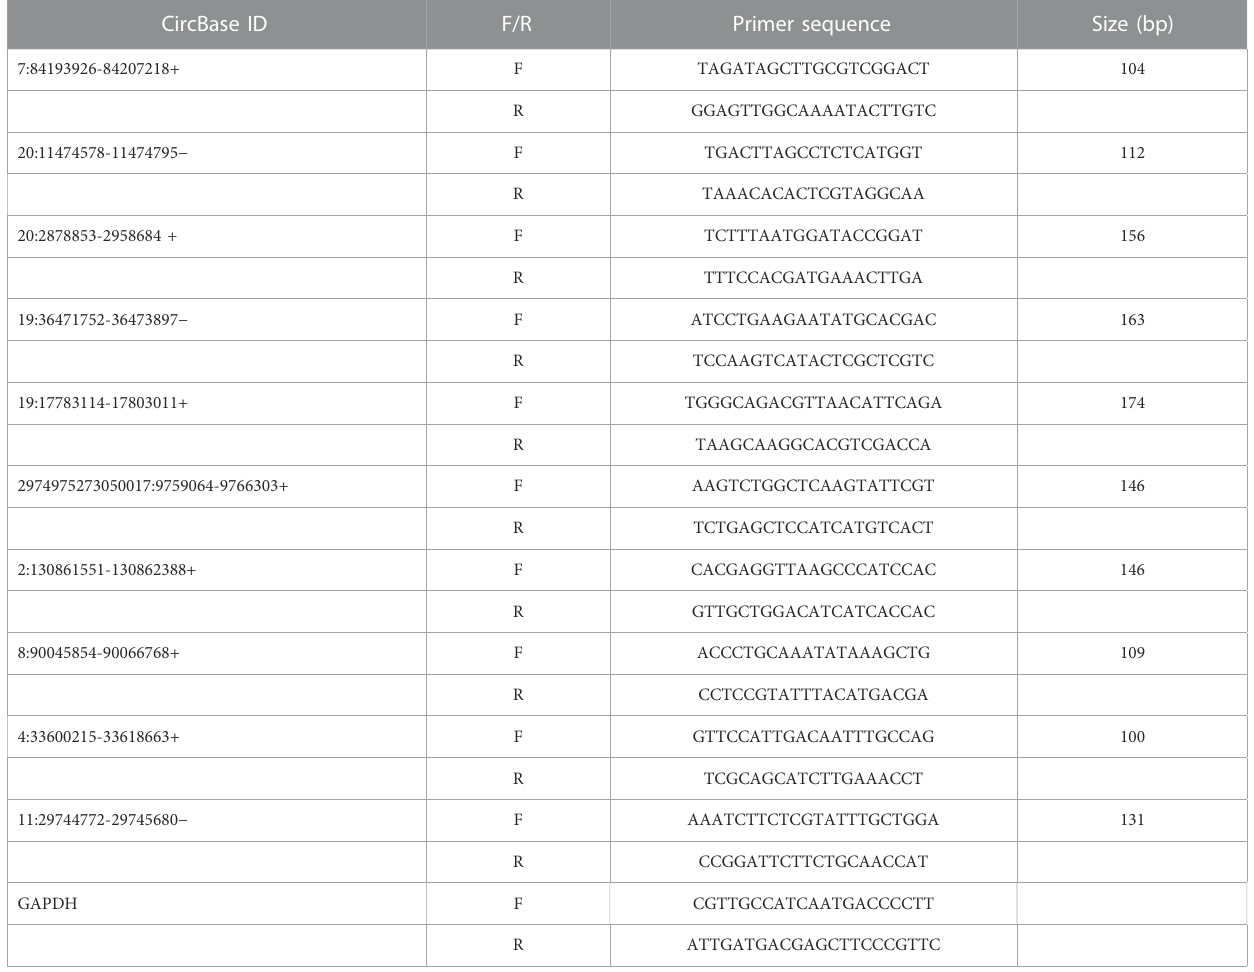
TABLE 1 Primer sequences for qRT-PCR validation of selected